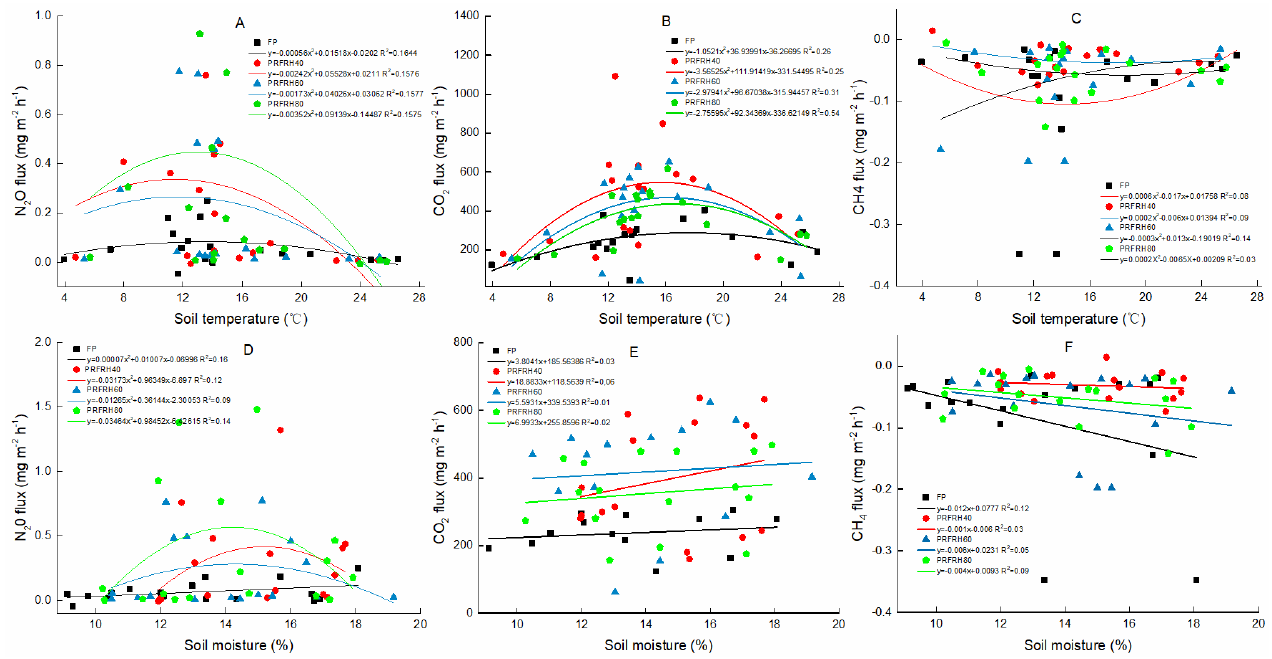
Figure 6. Correlation of N 2 O ( A , D ), CO 2 ( B , E ), and CH 4 ( C , F ) fluxes with soil temperature (°C) and moisture (%).